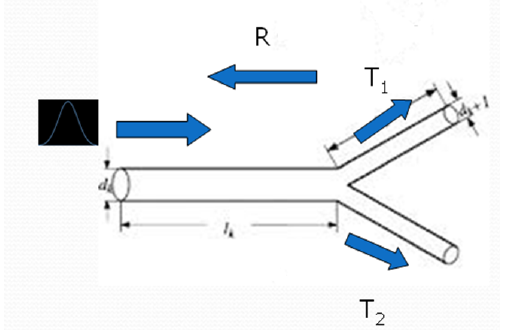
Figure 16. Schematic bifurcation in a power line.